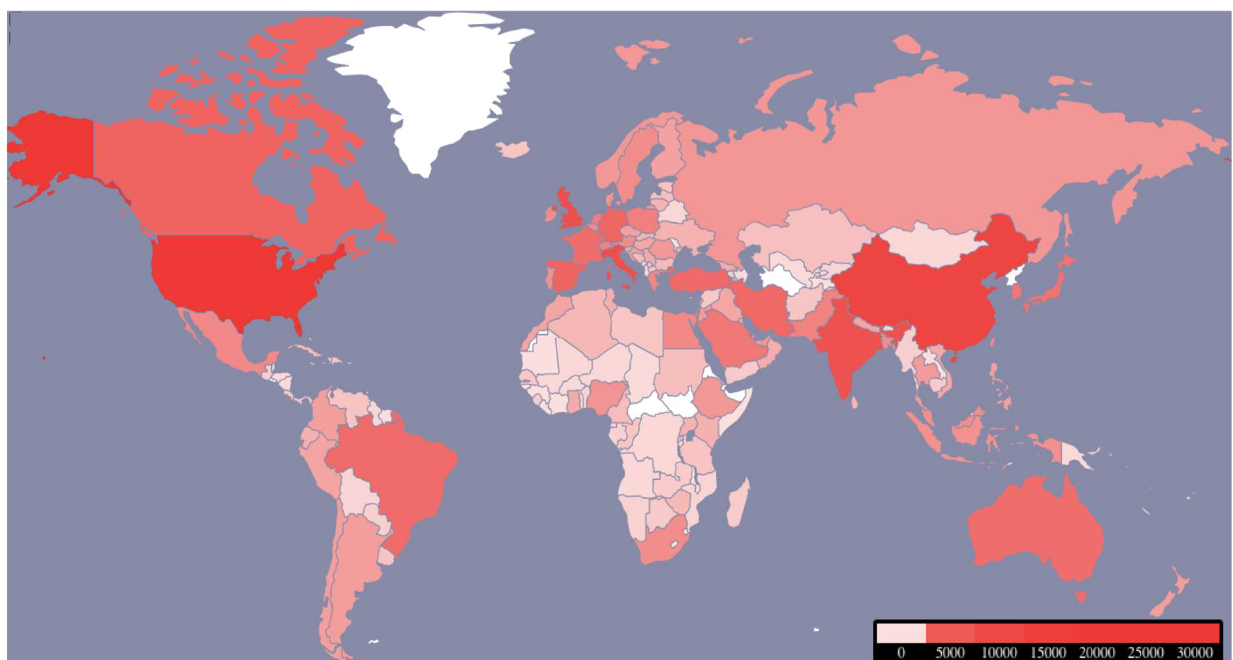
Figure 2. Geographical origin distribution of the 126,334 articles published on COVID-19